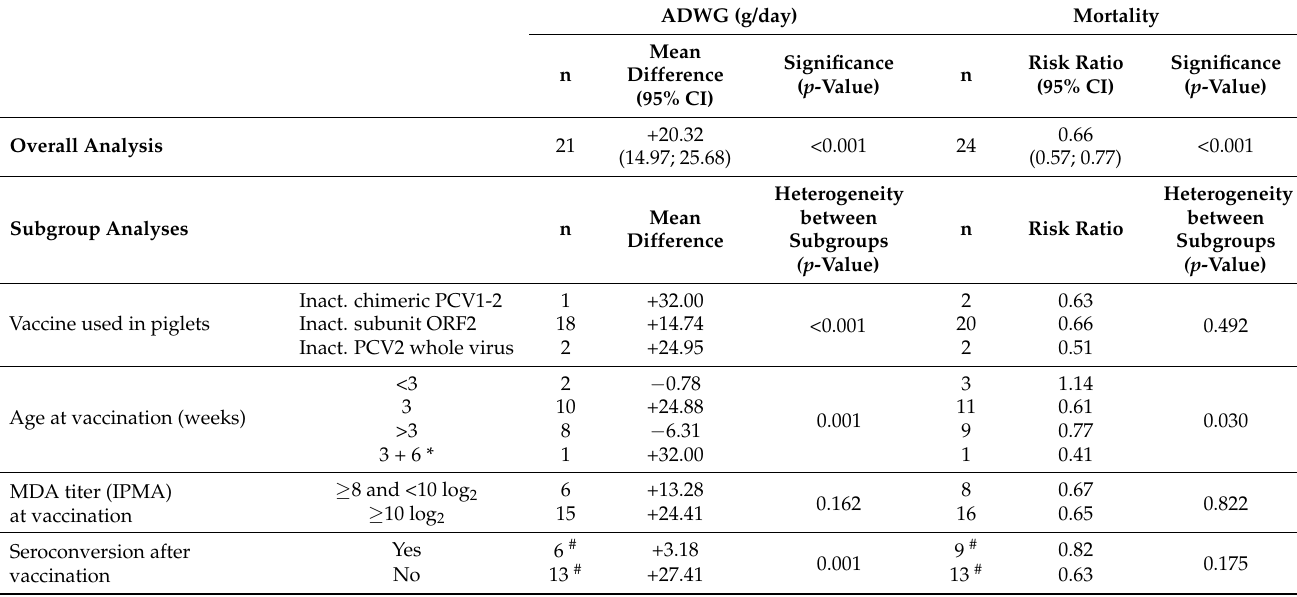
Table 3. Differences in production parameters (average daily weight gain and mortality) between vaccinated and unvacci- nated pigs with high levels of MDA at the age of vaccination against